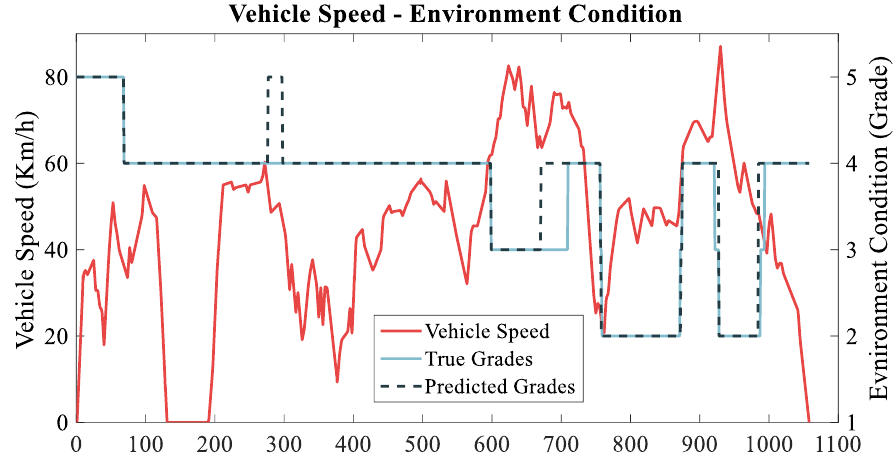
Figure 10. The prediction effect